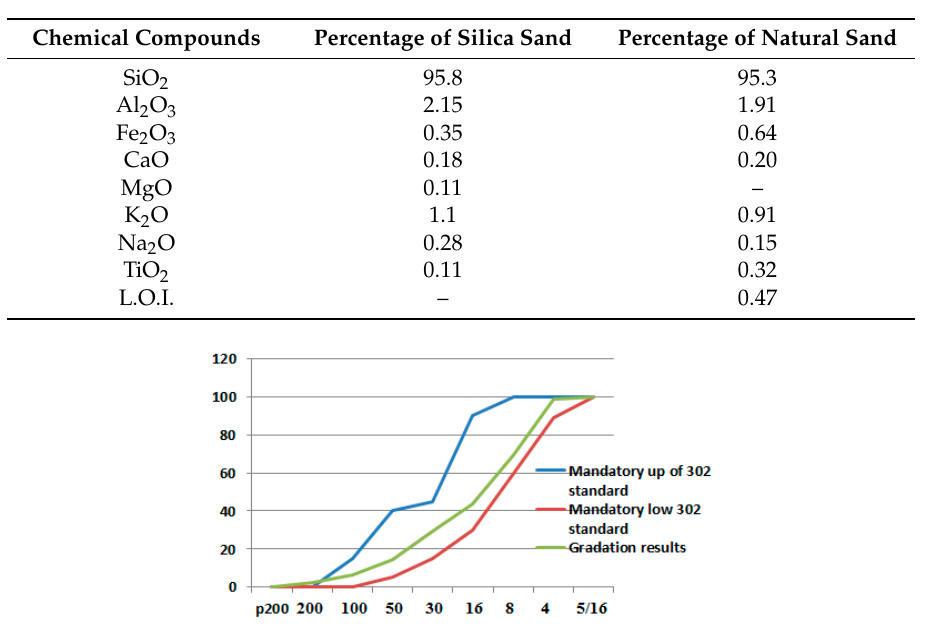
Table 7. Chemical characteristics of natural sand roving round of Ferbet and Qazvin silica sand.